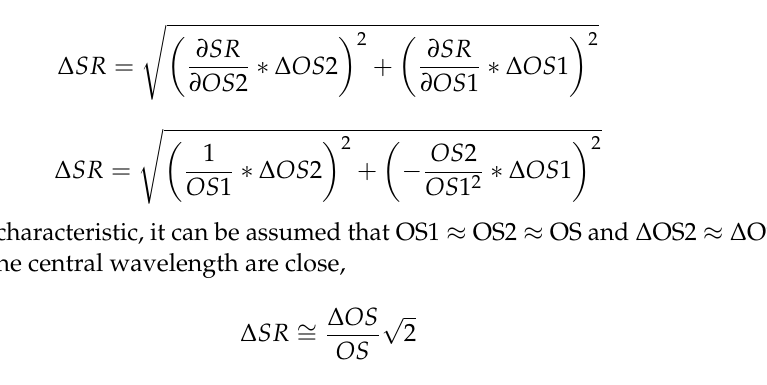
Figure 2. Mathcad simulation and OS1 experimental comparison, see text. For a better understanding of the shift between the curves see [6].